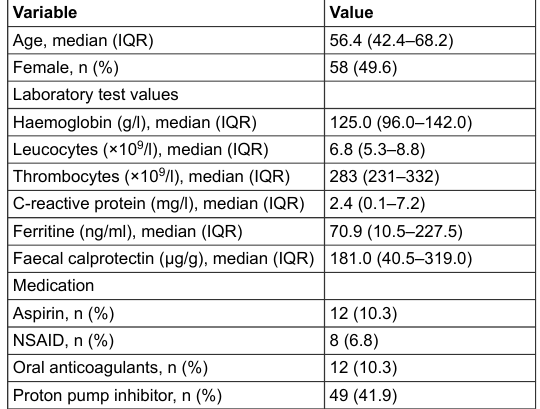
Table 1: Baseline characteristics.